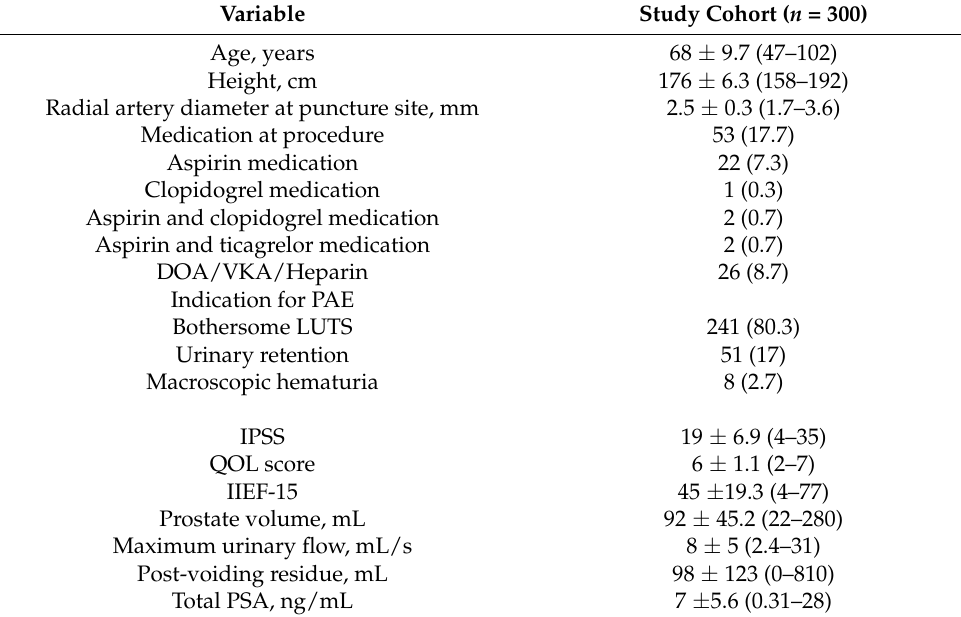
Table 1. Baseline characteristics of study cohort prior to